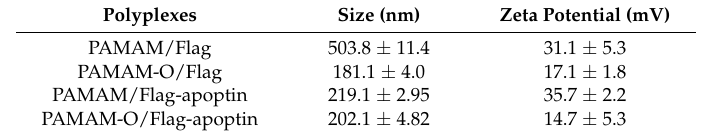
Figure 1. PicoGreen assay ( A ) and agarose gel retardation ( B , C ) of Flag or Flag-apoptin binding by the PAMAM-O dendrimer. Polyplexes were prepared with PAMAM and PAMAM-O dendrimers with Flag or Flag-apoptin at various weight ratios (0, 1, 2, 4, and 8). The signal intensity was normalized to 100% at a weight ratio of 0 (Flag only). Data represent mean ± standard deviation ( n = 3). Table 1. The characteristics of polymer/Flag or Flag-apoptin polyplexes. Polyplexes were incubated with Flag or Flag-apotin at a weight ratio (polymer:DNA) of 8:1. Data represent mean ± standard deviation ( n = 3) of three independent experiments.